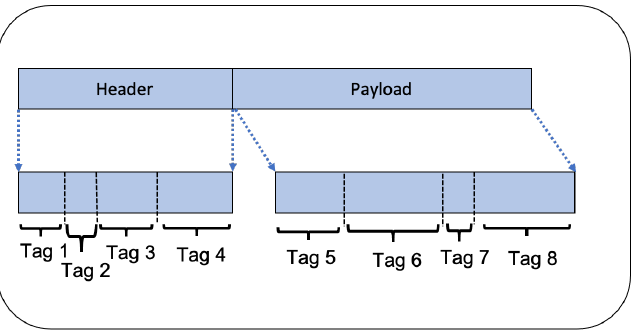
Figure 2. Message and its structural